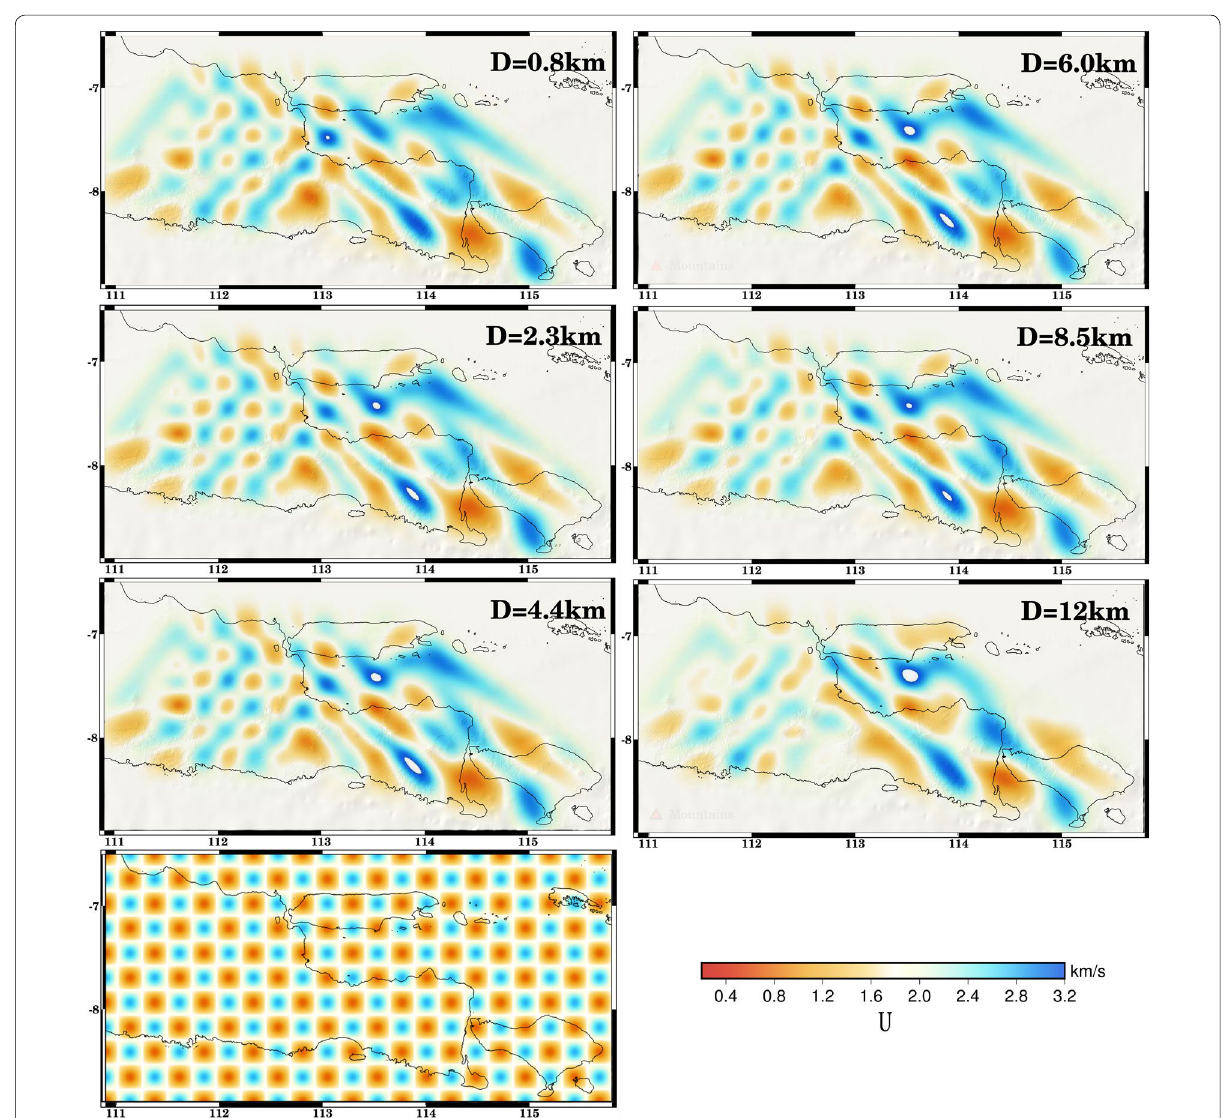
Fig. 4 Checkerboard test using damping and smoothing factors of 1800 and 1800,